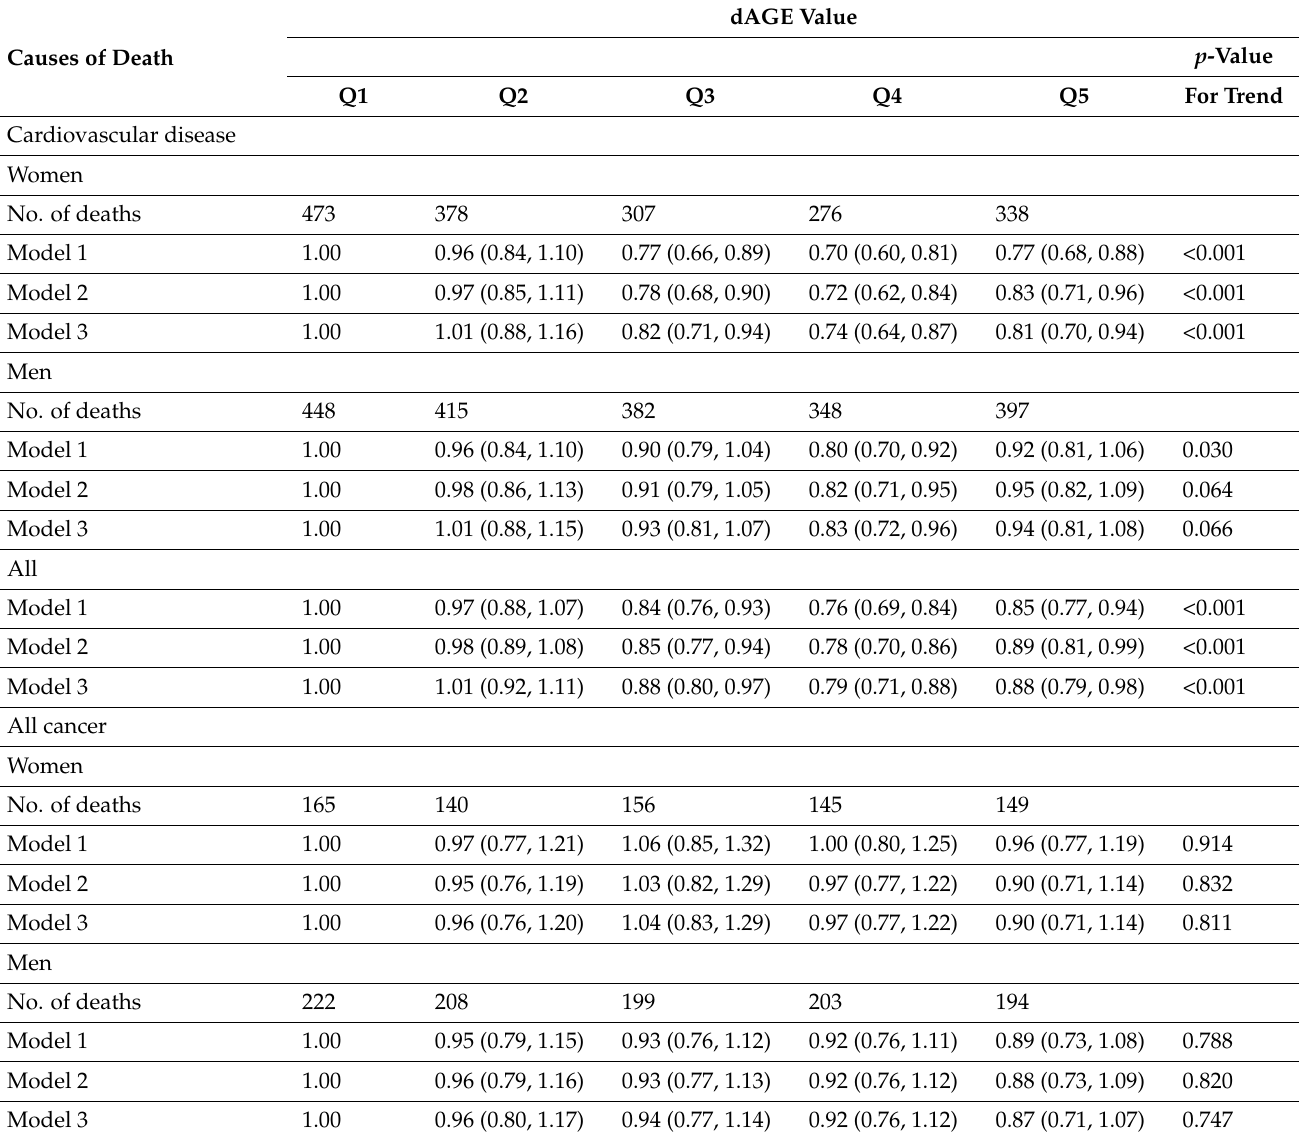
Table 3 presents HRs for cause-specific mortality, according to the dAGE quintiles. Participants at the highest quintile of dAGE had a lower risk of CVD mortality (HR: 0.88, 95% CI: 0.79, 0.98) compared to those in the first quintile, and the decreased risk was more evident in women. Adjusted HRs indicated no association of dietary dAGE intake with risk of mortality from all cancer (HR: 0.89, 95% CI: 0.76, 1.03), gastrointestinal (HR: 0.89, 95% CI: 0.72, 1.09), and other cancers (HR: 0.89, 95% CI: 0.71, 1.11). These findings did not differ in sex-specific analyses. Participants at the highest quintile of dAGE had a lower risk of death from other causes (than all cancers, respiratory and infectious diseases, and injuries) (HR: 0.79, 95% CI: 0.67, 0.92) compared to those in the first quintile, and the decreased risk was more evident in men. No association was observed between dAGE quintiles and death from infectious and respiratory diseases and injuries (Table 3). Table 3. Hazard ratios for cause-specific-mortality, according to the dAGE quintiles a